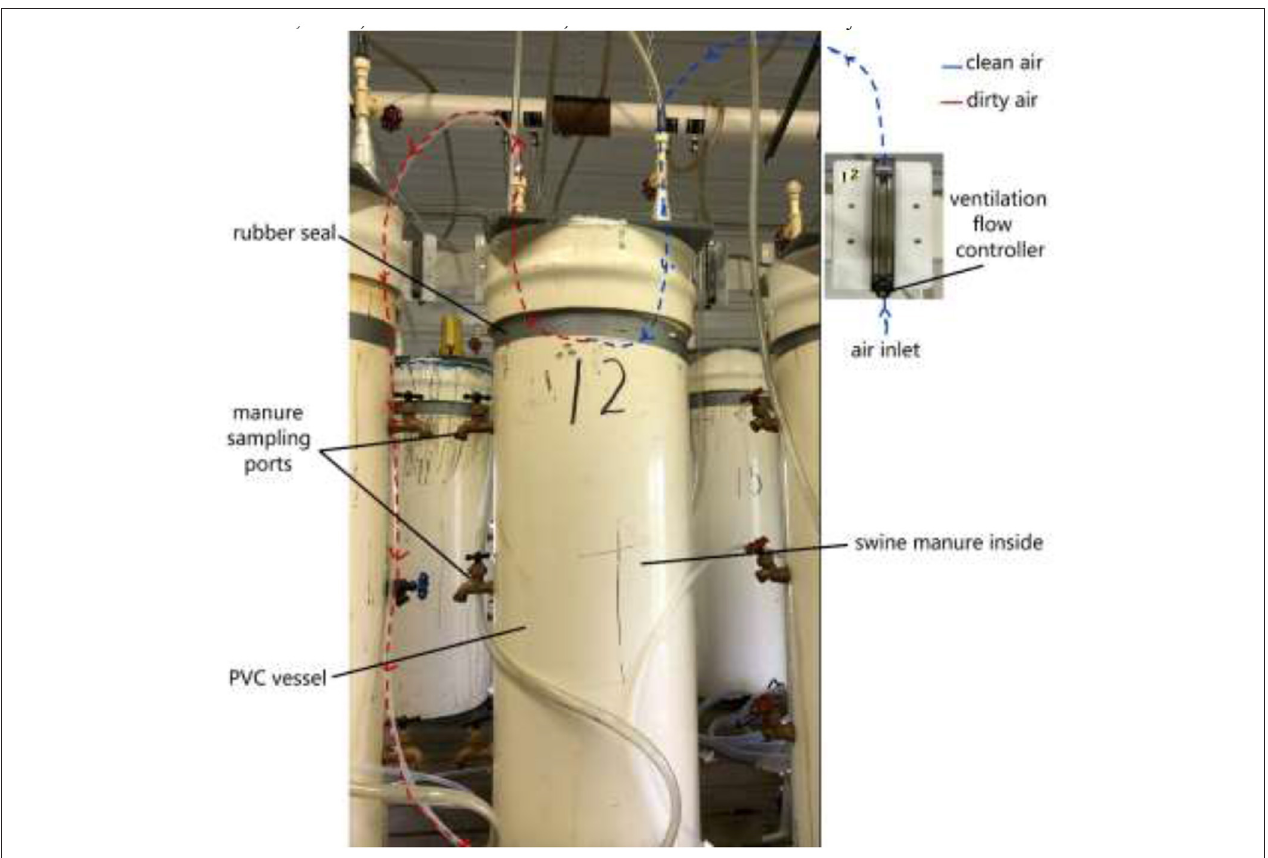
FIGURE 1 | Pilot-scale setup of manure storage simulator to test the effectiveness of manure additives for mitigation of gas emissions. Airflow in the headspace is measured and controlled by a rotameter with a needle valve for each simulator. Gas samples are collected from the “dirty air” outlet. The mitigation effect was estimated by comparing the gaseous emissions between treated and untreated